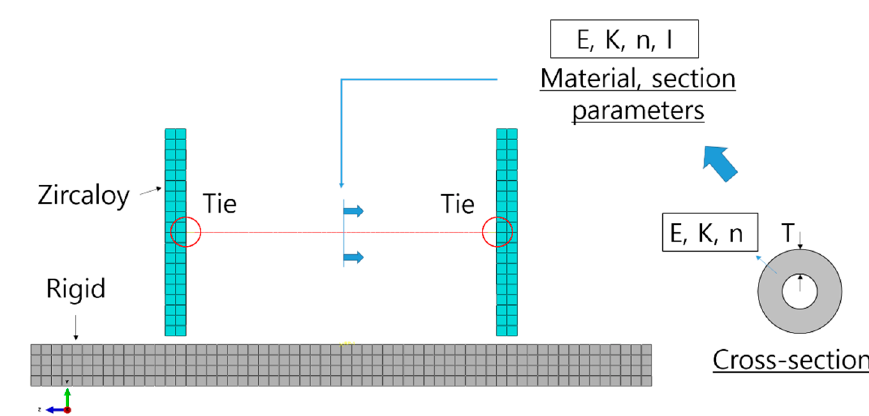
Figure 12. Model for the dynamic impact analysis (Detailed model).